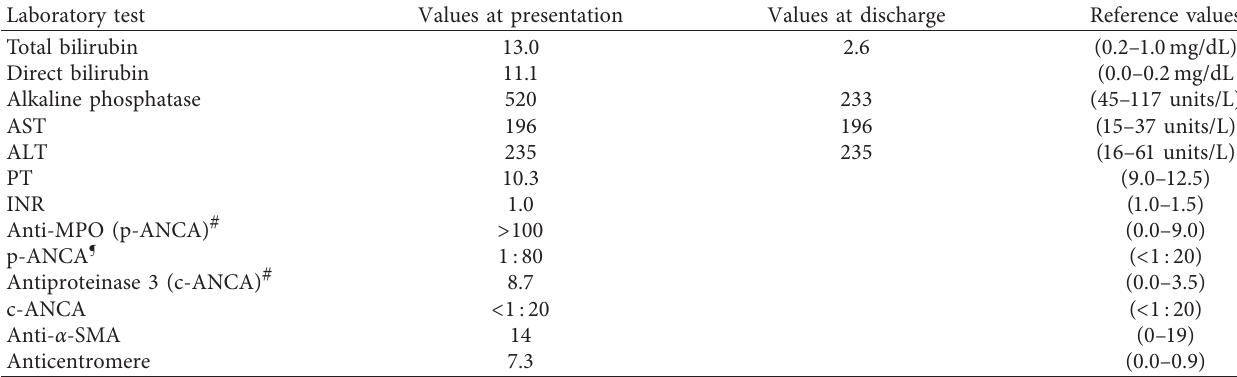
Table 1: Pertinent laboratory values.